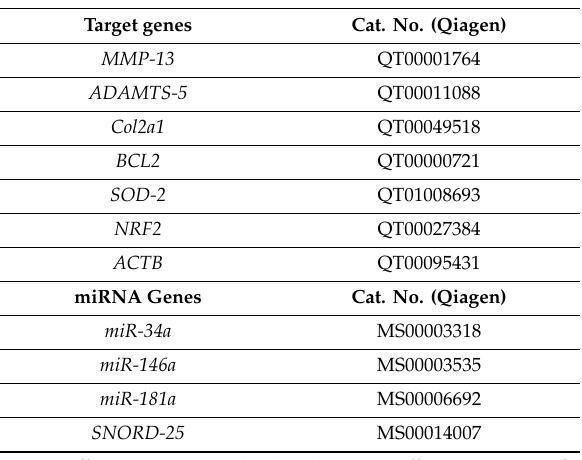
Table 1. Primers used for